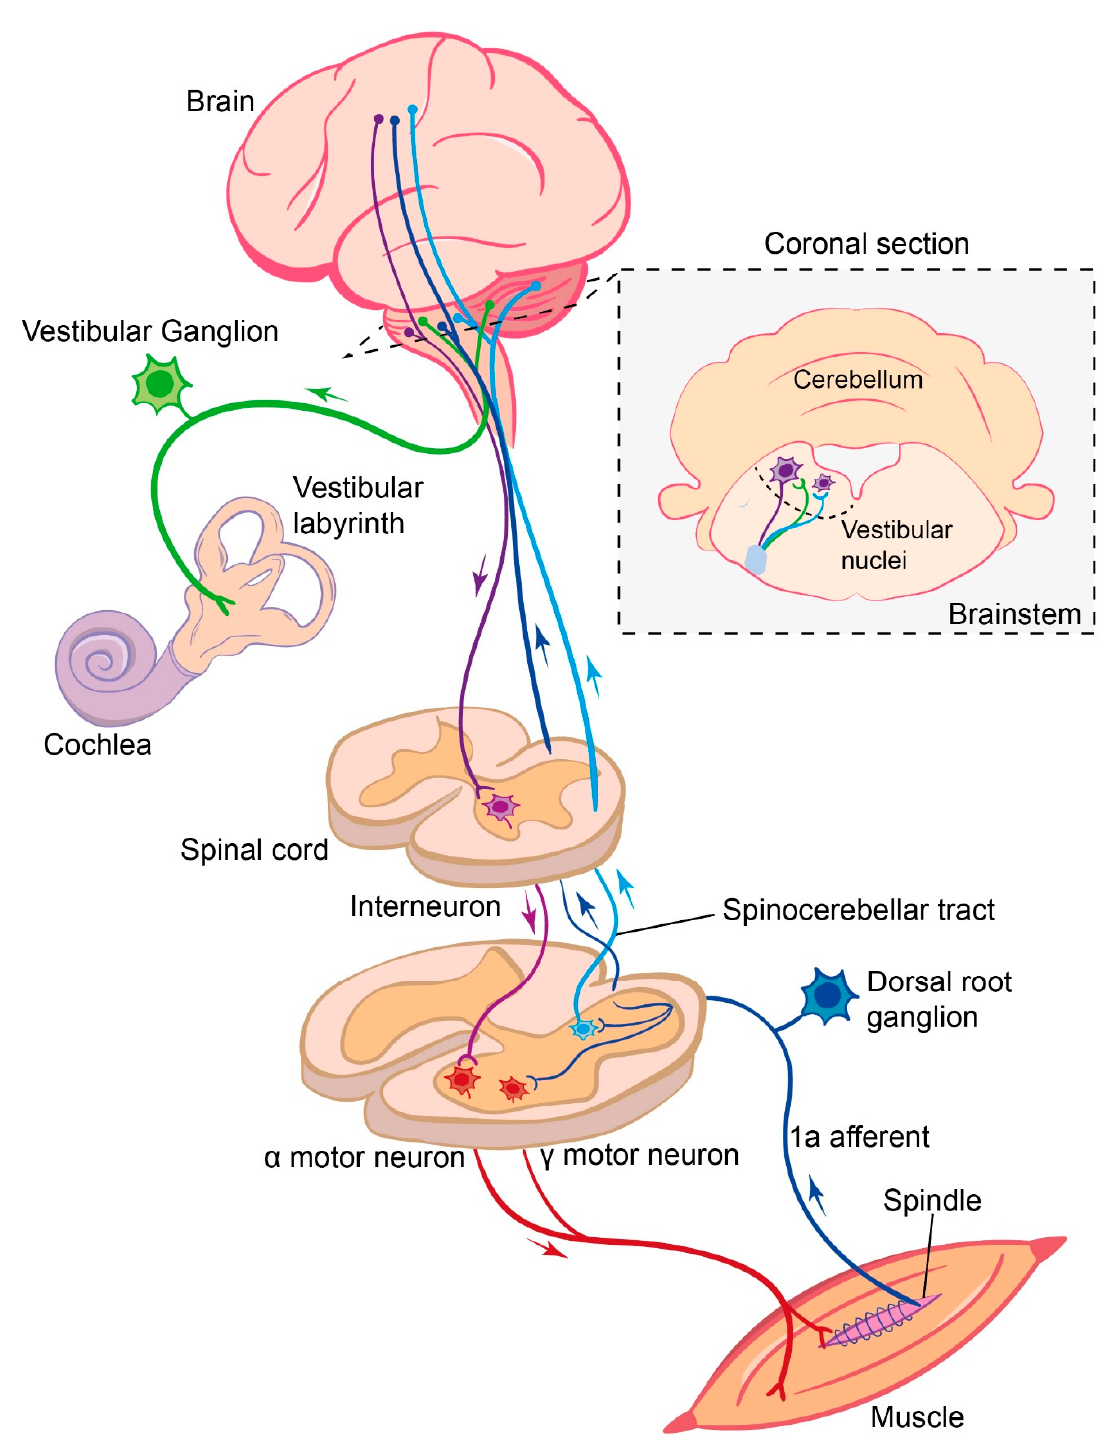
Figure 1. Summary of the somatosensory and vestibular sensory pathways and their integration into the brain and spinal cord.